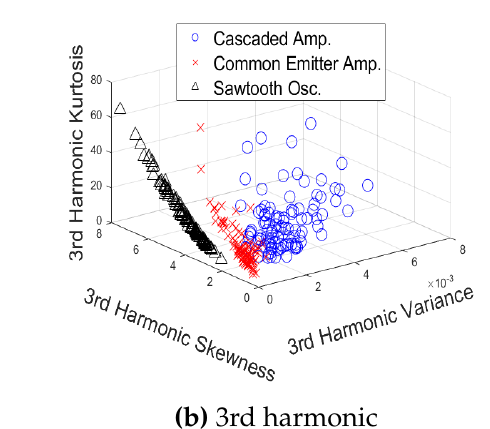
Figure 8. Classification performance of the statistical features for varying SNR values.